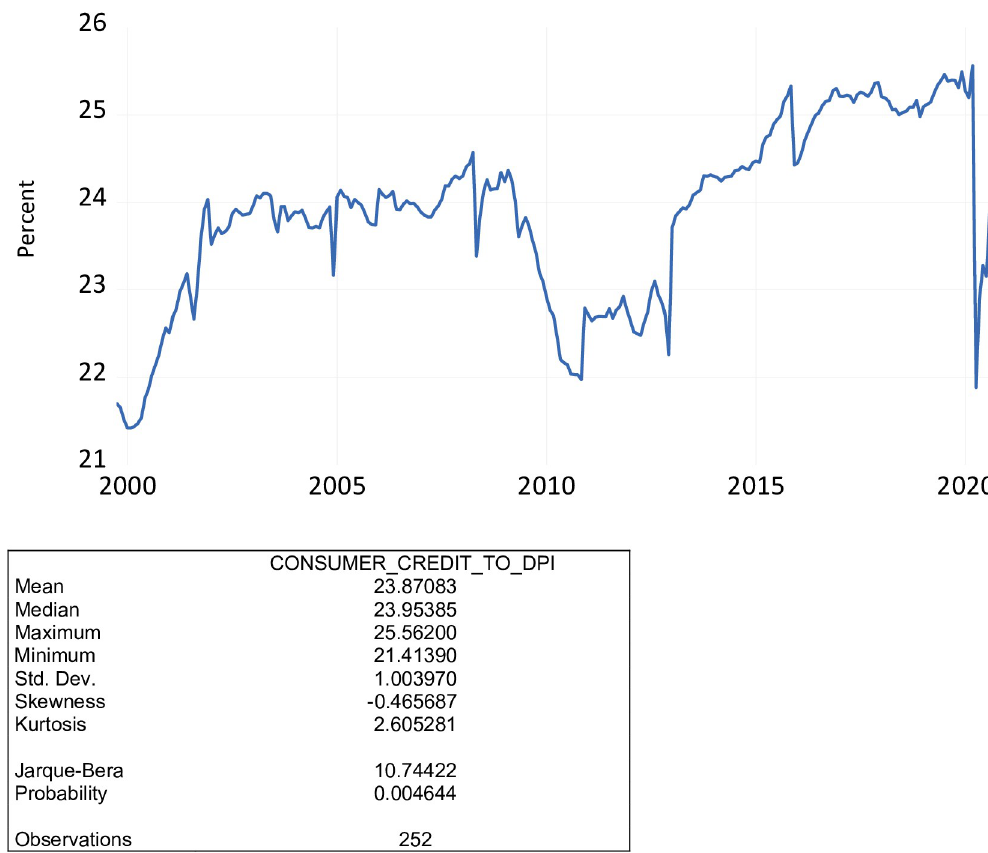
Fig 6. The ratio of consumer credit outstanding to disposable personal income, percent, October 1999 to September 2020.